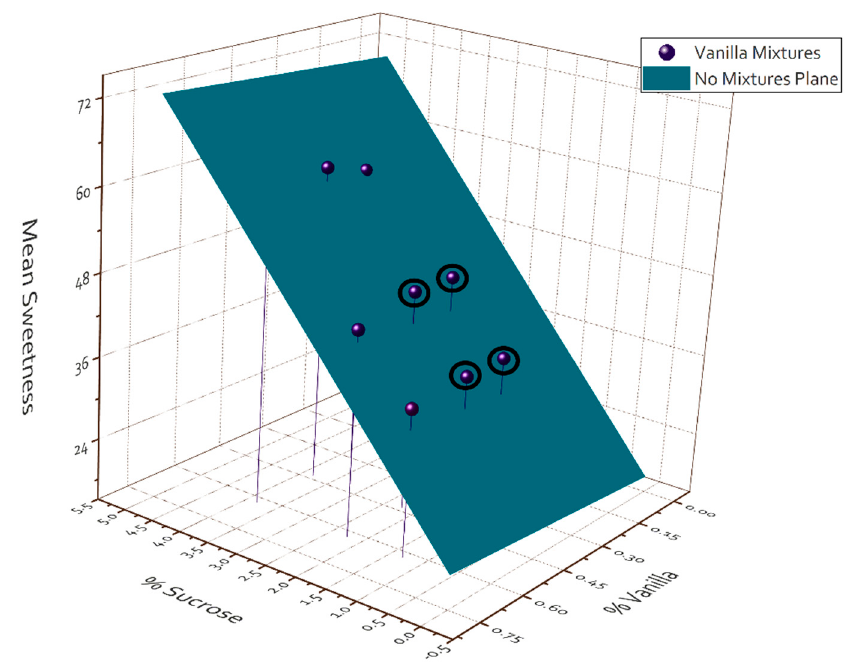
Figure 2. Isobologram for the vanilla-sucrose milks determined from their respective dose-response functions. Deviations above the zero-interaction surface correspond to I -values below 1 (synergy). Deviations below the surface correspond to I -values above 1 (antagonism). Those on or near the surface indicate no interaction ( I = 1). Mixtures that satisfied the working criterion are circled in black.